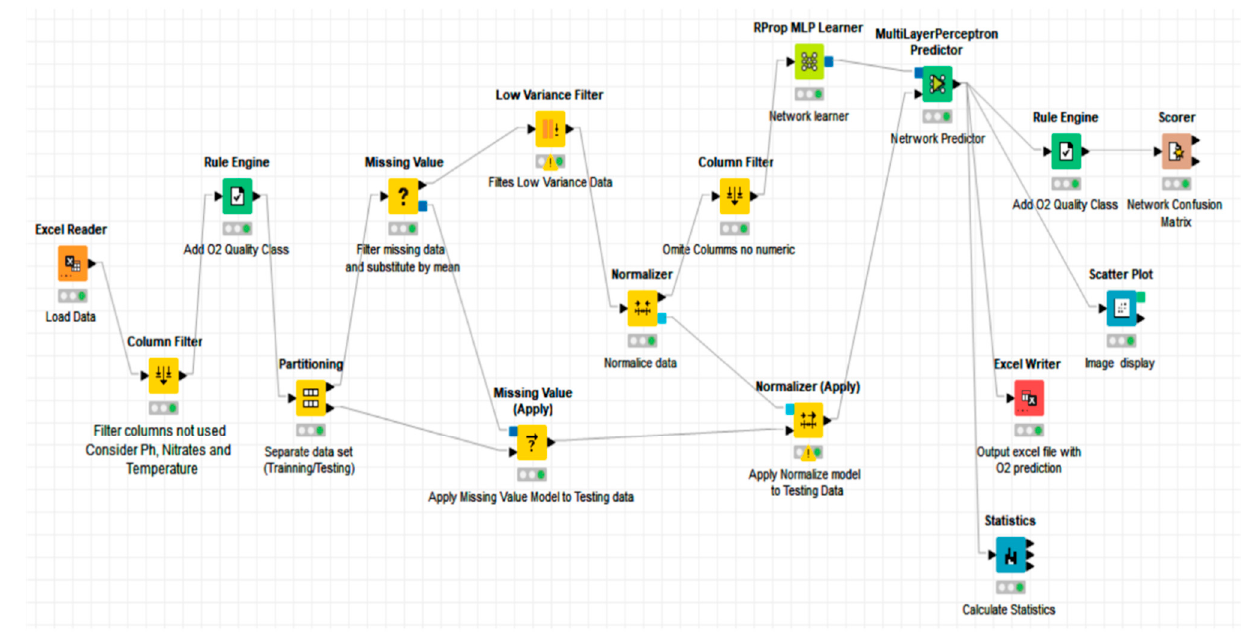
Figure 3. ANN flow chart.